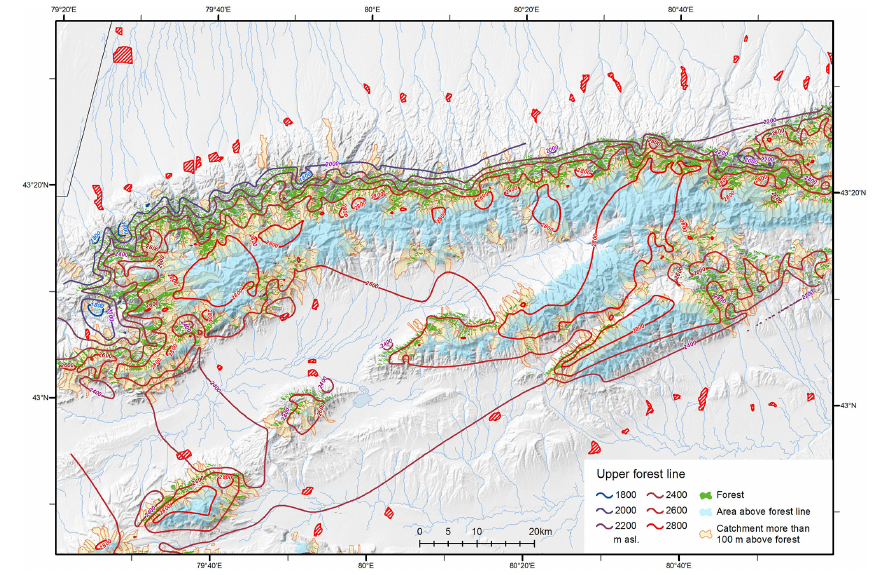
Figure 7. The upper forest line and the catchment areas providing upper forest line values in the investigation area.